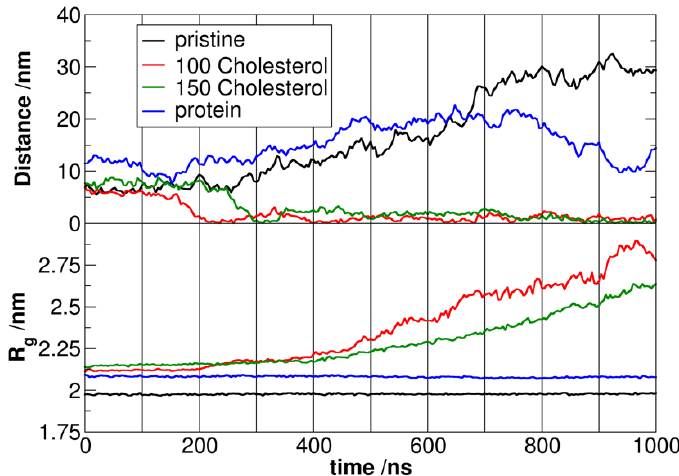
Figure 1. Development of the distances between the polystyrene particle and the DOPC bilayer in the four simulations (z component of the distance vector between the centers of mass, above), and that of the radius of gyration versus time (below).